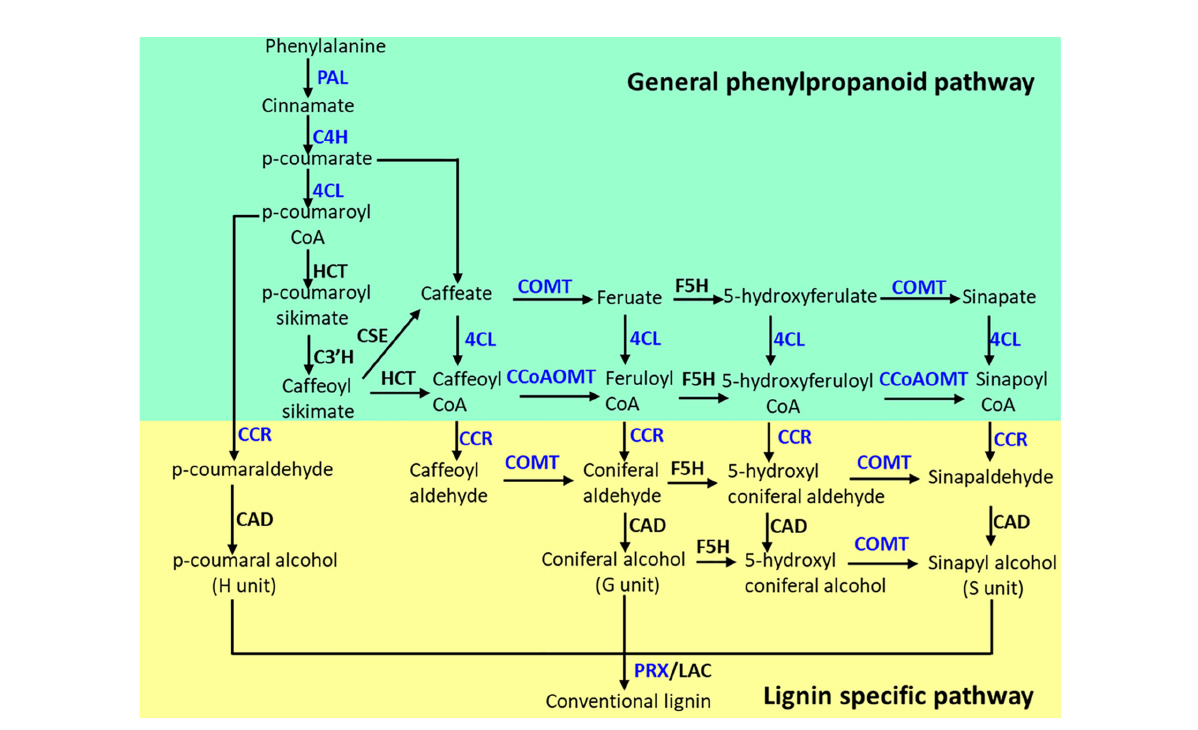
FIGURE 7 The phenylpropanoid (PP) and lignin-speci fi c pathways as in fl uenced by salt stress in alfalfa genotypes. Blue color indicates the genes were upregulated in Zhongmu (ZM) and/or Xingjiang Daye (XJD) under salt stress. The genes that did not show signi fi cant changes in expression are indicated in black color. PAL, phenylalanine ammonia-lyase; C4H, cinnamate 4-hydroxylase; 4CL, 4-coumarate CoA ligase; CHS, chalcone synthase; HCT, hydroxycinnamoyl CoA:shikimate/quinate hydroxycinnamoyl transferase; CCoAOMT, caffeoyl CoA 3-O-methyltransferase; F5H, ferulate 5-hydroxylase; COMT, caffeic acid O-methyl transferase; CCR, cinnamoyl CoA reductase; CAD, cinnamyl alcohol dehydrogenase; PRX,